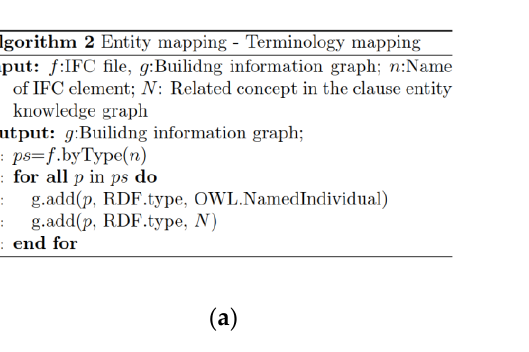
Figure 8. Packaged algorithms of entity mapping rule development: ( a ) terminology mapping rules; ( b ) decomposed mapping rules for specific IFC entities.